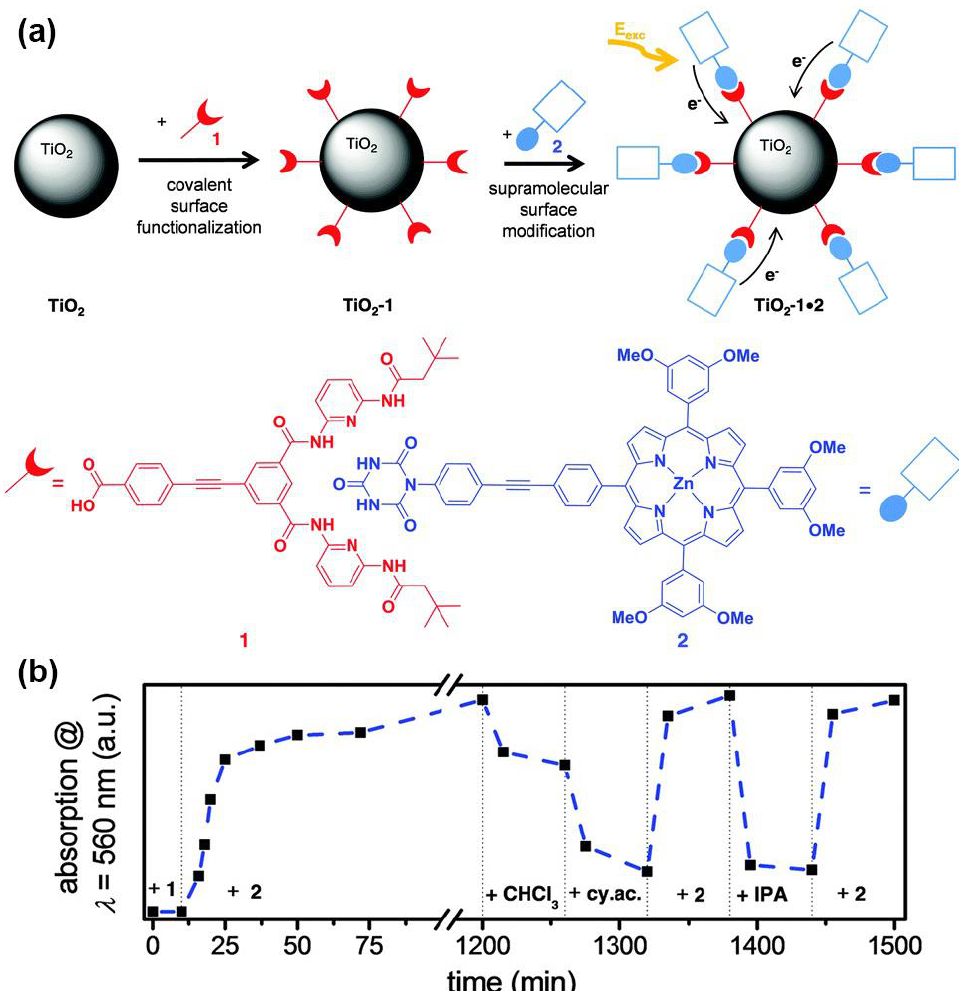
Figure 19. ( a ) Conceptional sketch of the supramolecular self-assembly of porphyrins onto TiO 2 nanoparticles by means of hydrogen bonding interactions and ( b ) time-dependent UV–visible study for an illustration of the reversibility of the self-assembly of porphyrin 2 on Hamilton receptor-modified TiO 2 layers (absorption at 560 nm vs. time). Adapted from reference [84] with permission from the Royal Society of Chemistry, copyright 2016.